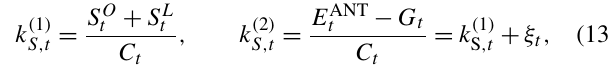
We report parameter estimates for the standard deviations σ (cid:15) and σ η and slope coefficient β together with its standard error (SE) and t statistic ( t -stat). We further report the normality ( N ) test, the goodness-of-fit statistic R 2 D , and the Durbin–Watson (DW) test statistic for serial correlation; all are computed for the standardized prediction errors u t , which are obtained from the Kalman filter. The normality test N is the χ 2 distributed, with 2 degrees of freedom, statistic of Jarque and Bera (1987), with its 95% critical value of 5 . 99 ; the statistic relies on the sample estimates of skewness and kurtosis of u t . The goodness-of-fit statistic R 2 d is defined as 1 − ESS/DSS , where ESS = P n t = 2 u 2 t